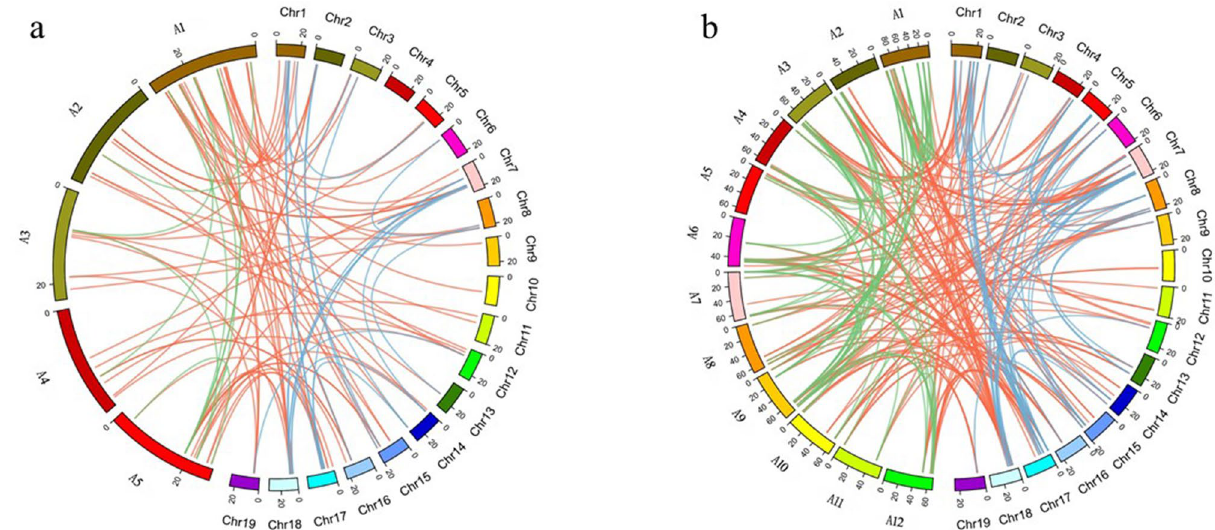
Figure 4. The analysis of paralogous bHLH genes and their orthologues in grape, Arabidopsis and tomato. ( a ) The analysis of paralogous and orthologues in grape (Chr1-Chr19) and Arabidopsis (A1-A5). The blue lines represent the paralogous bHLH genes in grape. The green lines represent the paralogous bHLH genes in Arabidopsis . The red lines represent their orthologous bHLH genes. ( b ) The analysis of paralogous and orthologues in grape (Chr1-Chr19) and tomato (A1-A12). The blue lines represent the paralogous bHLH genes in grape. The green lines represent the paralogous bHLH genes in tomato. The red lines represent their orthologous bHLH genes. The relationships of orthologous and paralogous bHLH genes among grape, Arabidopsis and tomato were drawn by Circos 0.69.6 (http:// circos. genes was less than three times that of grapes. These results indicate that a large number of gene losses occur in WGD of tomato. We use OrthoMcl to analyze the orthologous bHLH genes in grape, Arabidopsis and tomato genome. We found 138 bHLH orthologous gene pairs between grape and tomato, but only 69 bHLH orthologous gene pairs between grape and Arabidopsis (Supplementary Table S5). The result was consistent with the close